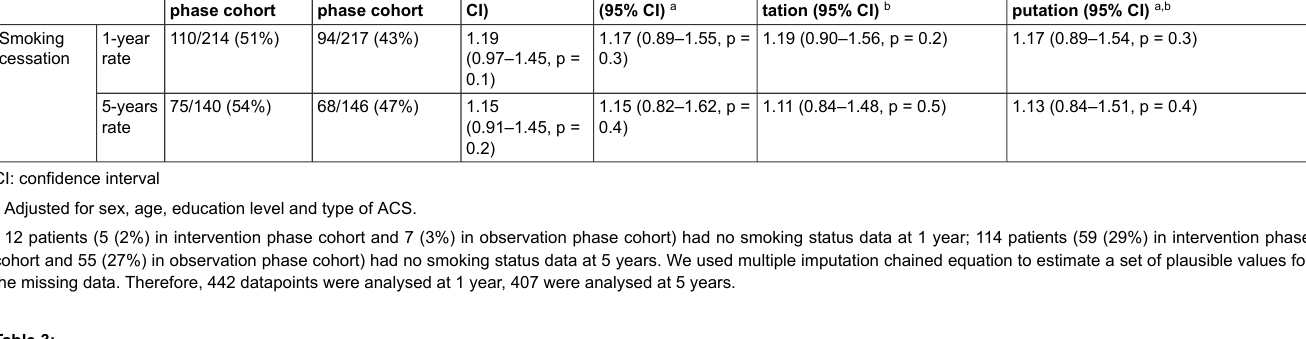
Table 2: Smoking cessation prevalence comparing participants in the smoking cessation intervention phase cohort with the observation phase cohort at 1 year (n = 431) and 5 years (n = 286) after the index acute coronary syndrome (ACS), with or without multiple imputation for missing data. Intervention phase cohort